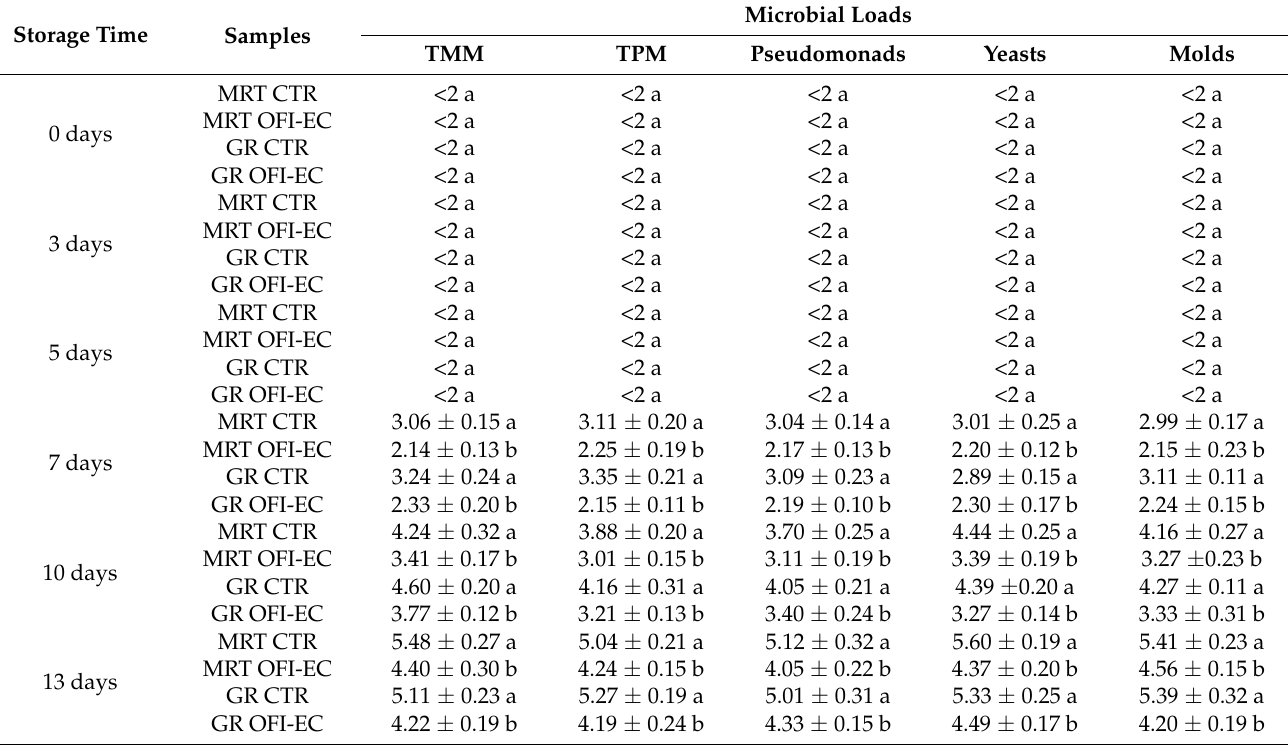
Table 4. Microbial loads of untreated and coated loquat